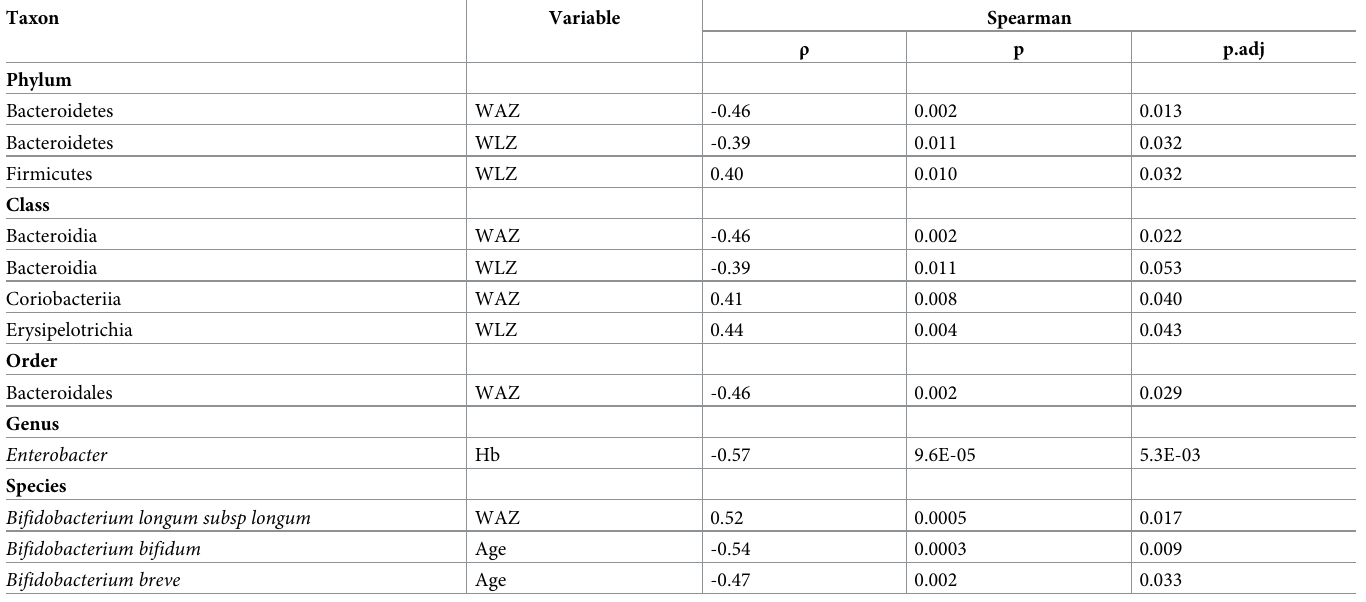
Table 2. Association of fecal microbiota with nutritional status indicated by length-for-age (LAZ), weight-for-age (WAZ) and weight-for-length (WLZ) Z-scores determined by Spearman correlation analysis.